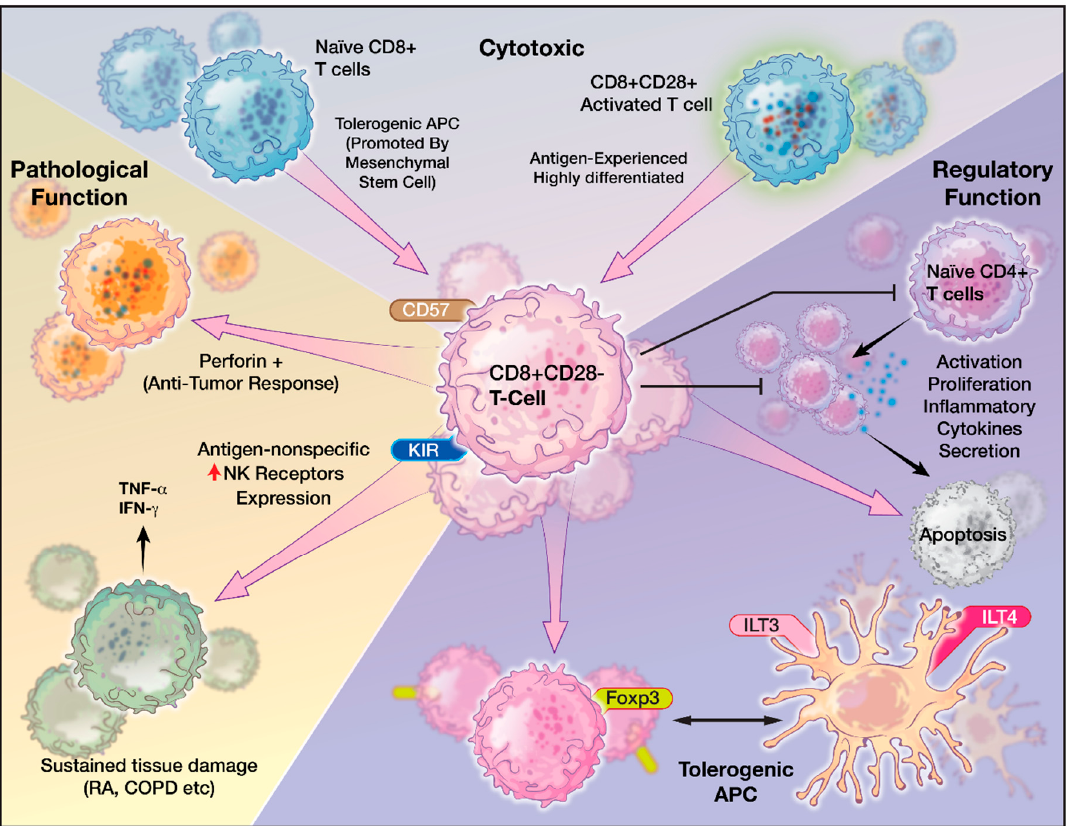
Figure 3. The heterogeneous functions of CD8 + CD28 − T cells. CD8 + CD28 − T cells originate from activated CD8 + CD28 + T cells or from interaction with tolerogenic APCs. CD8 + CD28 − T cells exhibit both cytotoxic and immunoregulatory phenotypes and vary in pathological states such as across different cancer types or inflammatory/autoimmune conditions.